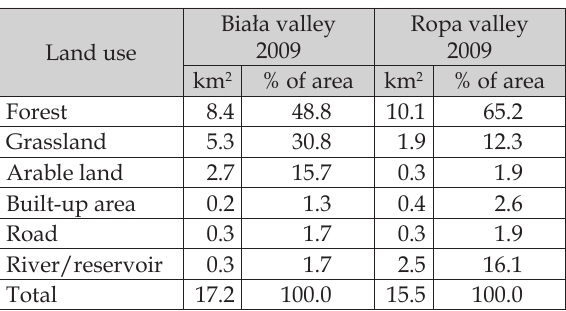
Table 2. land use in the tested area of the Biała and Ropa valley in